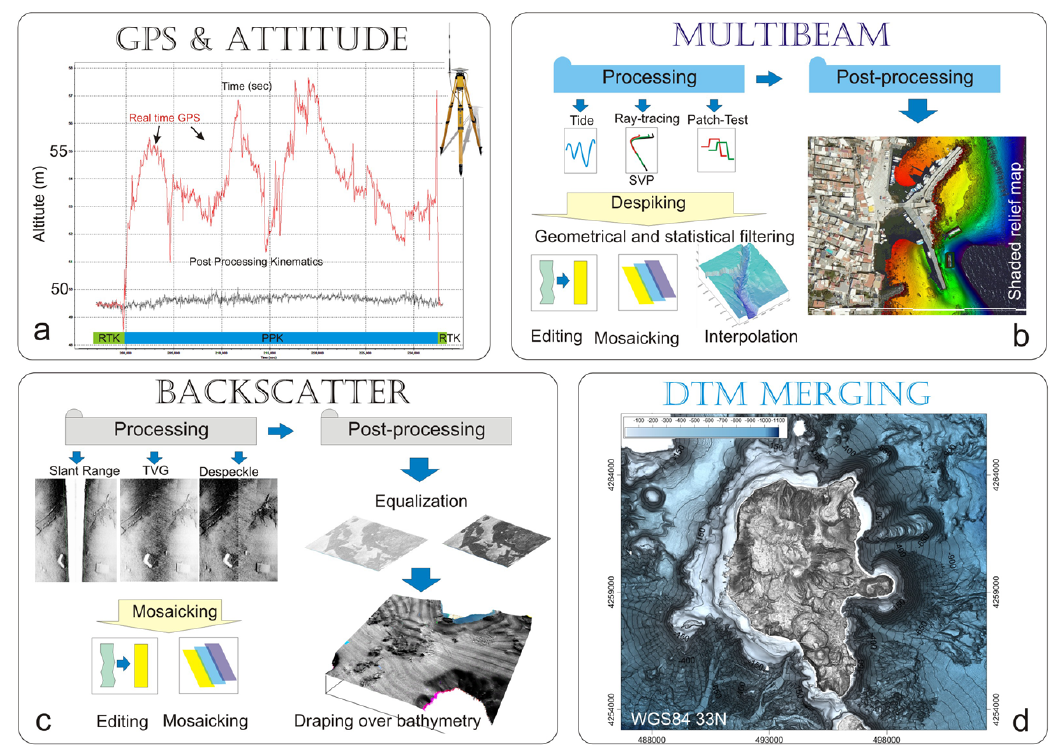
Figure 5. Flow chart of the multibeam data processing: (a) GPS and attitude; (b) bathymetric data; (c) backscatter data; (d) DTM merging. See text for details.